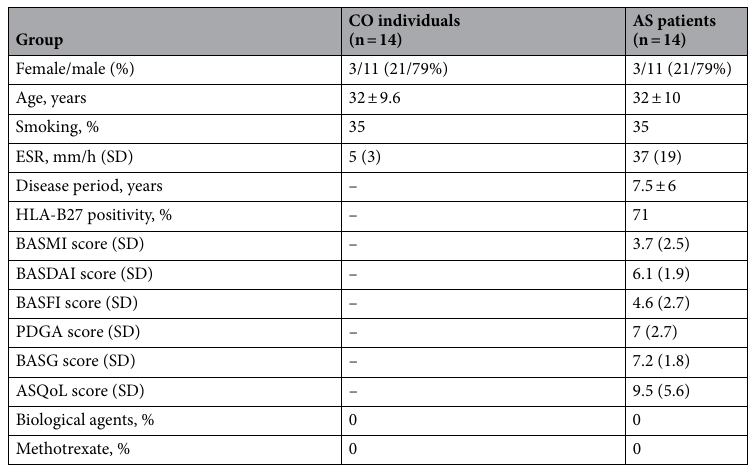
Table 4. Clinical and demographical features of healthy individuals and AS patients. AS ankylosing spondylitis, CO control, ESR erythrocyte sedimentation rate, HLA-B27 human leukocyte antigen (subtypes B*2701-2759), BASMI Bath Ankylosing Spondylitis Metrology Index, BASFI: Bath Ankylosing Spondylitis Functional Index, BASDAI: Bath Ankylosing Spondylitis Disease Activity Index, BAS-G: Bath